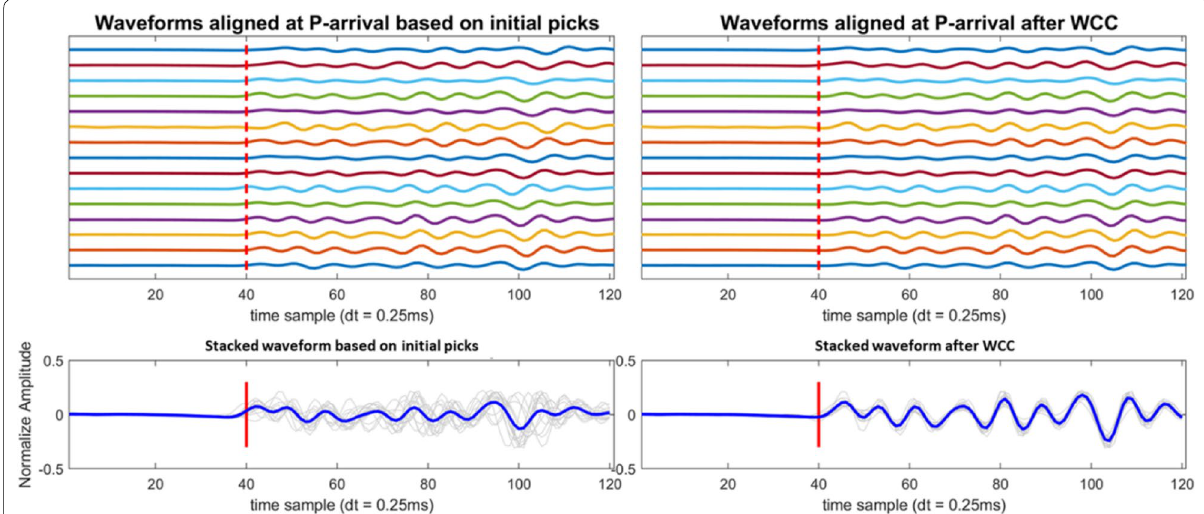
)(See figure on next Fig. 3 Dissimilarity matrix of microseismic event pairs sorted by chronological order ( a ), and reordered following the clustering result ( b